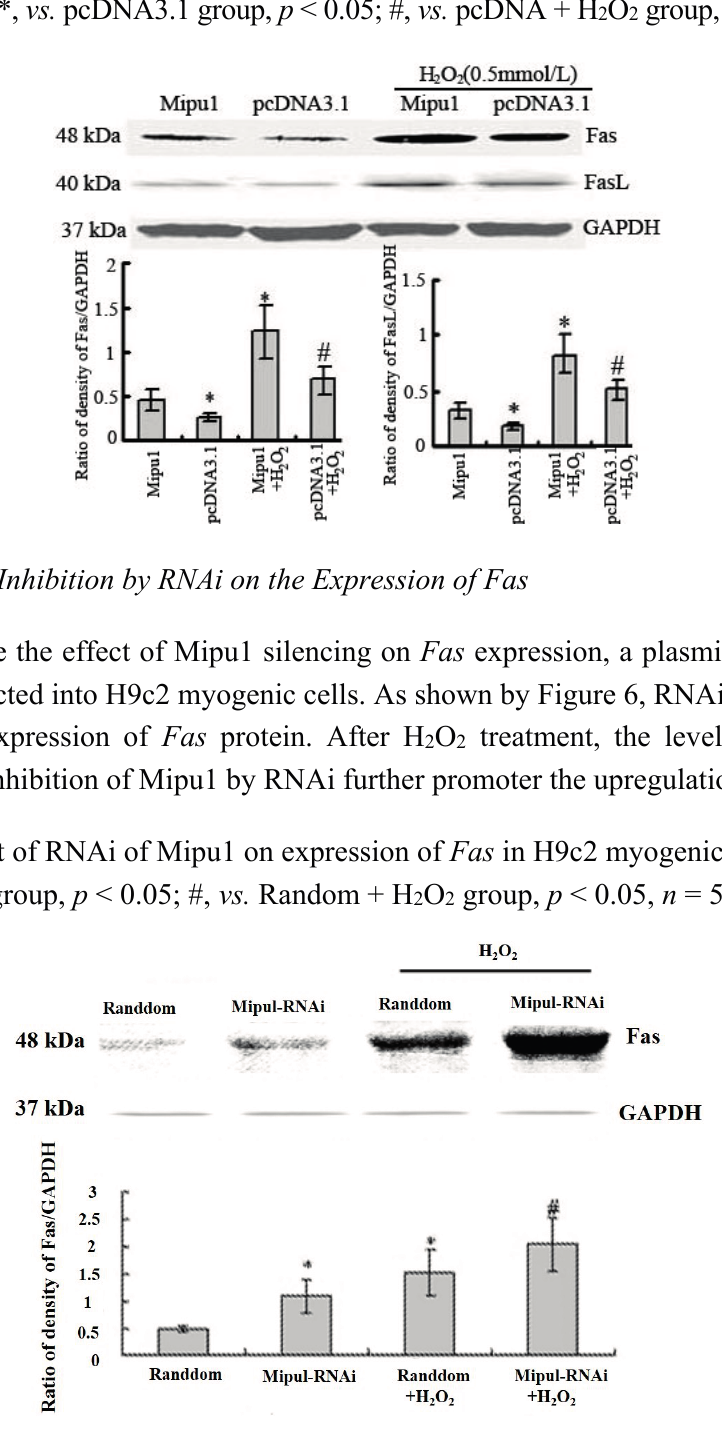
myogenic cells. *, vs. pcDNA3.1 group, p < 0.05; #, vs. pcDNA + H 2 O 2 group, p < 0.05, n =